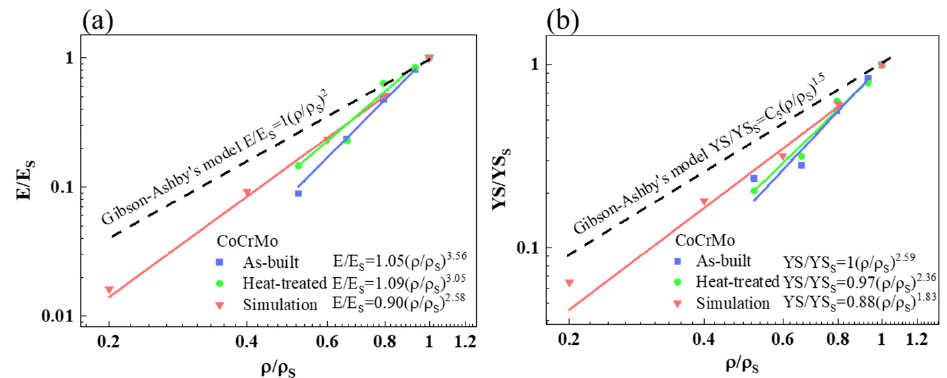
Figure 8. ( a ) The relative elastic modulus and ( b ) relative yield strength obtained from the analytical, simulated, and experimental results versus a logarithmic scale of relative density in the as-built and heat-treated CoCrMo alloys.